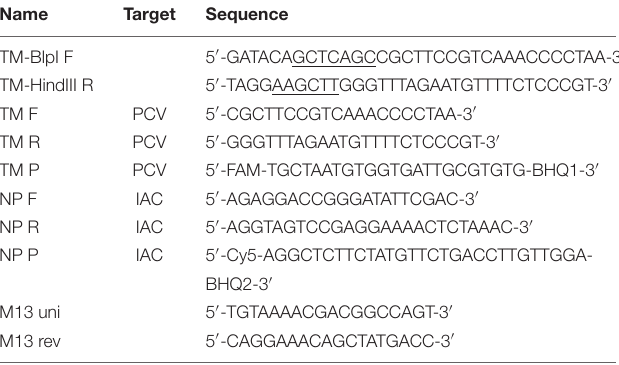
TABLE 1 | Specific oligonucleotides used in the present